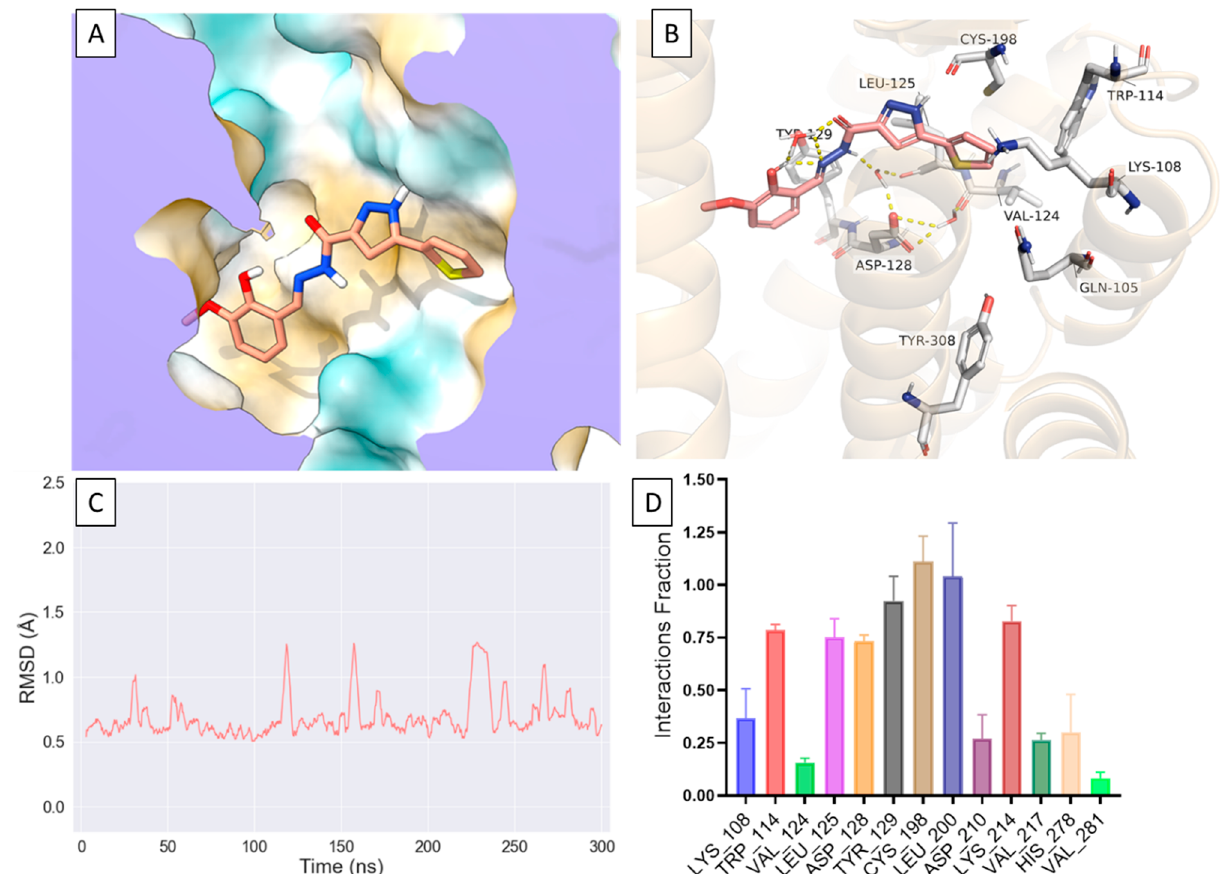
Figure 5. Molecular Dynamic simulation of Compound 1 binding to the δ OR . ( A ) . Compound 1 bound at δ OR where its positioned within the hydrophobic pocket, a predicted allosteric site. ( B ) . Compound 1 interacts with residues forming the hydrophobic pocket as well as with residues deeper into the orthosteric site K108 2.63 , W114 ECL1 , L125 3.29 , D1283 .32 , Y129 3.33 , C198 ECL2 , L200 ECL2 and K214 5.40 . ( C ) . A rolling average of 3 ns of the RMSD of compound 1 in a 300 ns MD simulation showing a relatively stable binding pose for compound 1 . ( D ) . Interaction fractions between compound 1 and the δ OR in 3 different MD simulations.